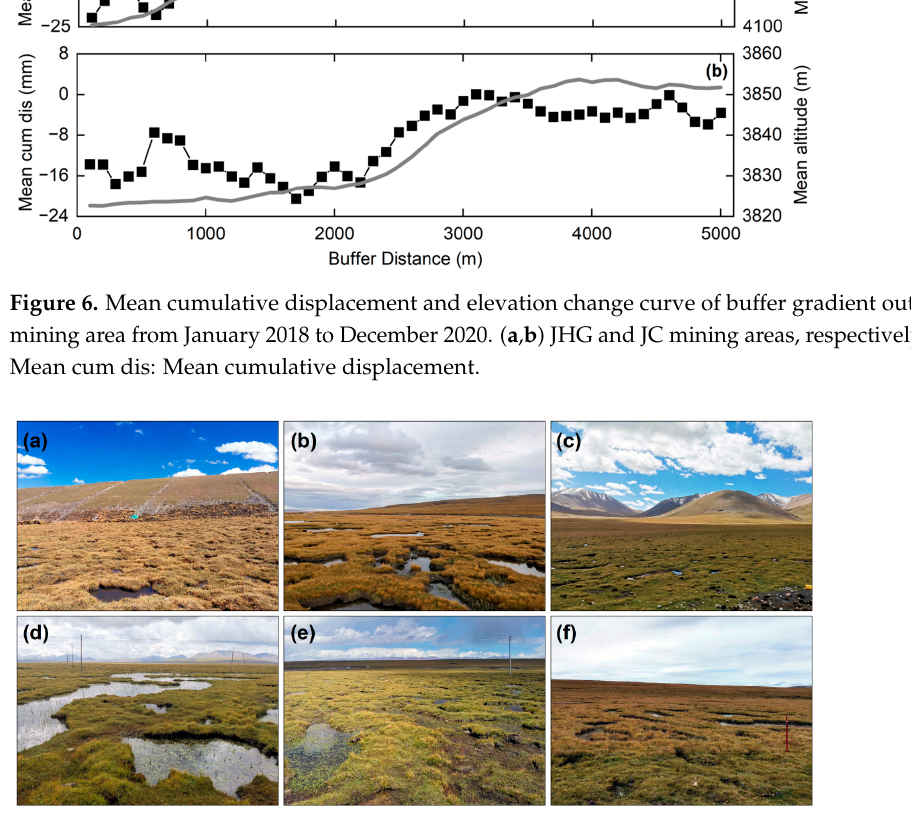
Figure 7. Field photos of alpine marsh meadow in different buffer zones outside mining area. ( a ) JHG coal mine No. 6, 0–100 m buffer zone; ( b ) JHG coal mine No. 4, 100–200 m buffer zone; ( c ) JHG coal mine No. 6, 700–800 m buffer zone; ( d ) JC coal mine No. 2, 100–200 m buffer zone; ( e ) JC coal mine No. 2, 700–800 m buffer zone, and; ( f ) JC coal mine No. 3, 1100–1200 m buffer